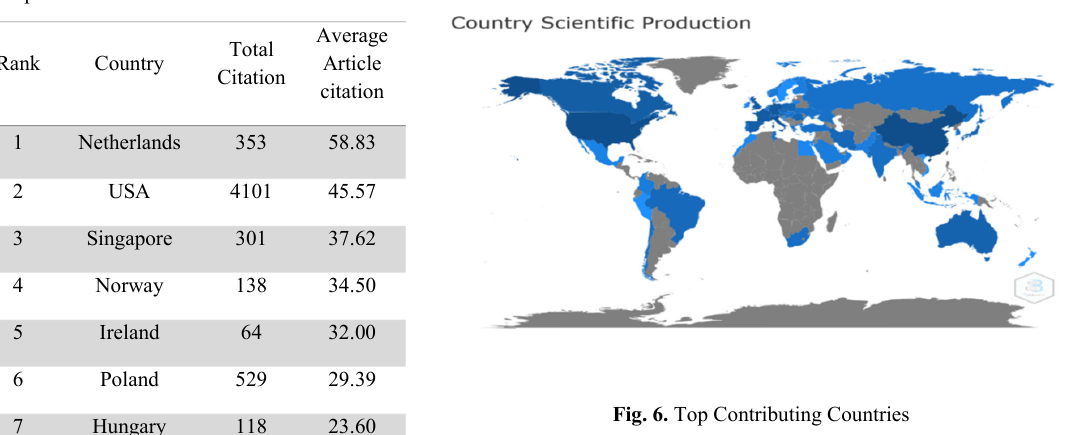
Fig. 6. Top Contributing Countries